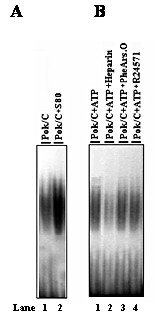
EMSA showing enhancement of binding activity of Nonabokra NE with 32P-1X ABRE-DNA after addition of the S80 fraction. A. Enhancement of the binding intensity by pre-incubation of control NE from Nonabokra with S80 fraction prepared from Nonabokra (200 mM NaCl for 16 hrs; lane 2). In lane 1, no S80 fraction was added. B. EMSA showing enhancement of complex formation after addition of ATP (lane 1). Partial inhibition of binding was obtained with heparin (a potent inhibitor of casein kinase II, lane 2), whereas no inhibition was obtained with phenyl arsine oxide (an indirect inhibitor of MAP kinase, lane 3) or R24571 (a potent inhibitor of CDPK, lane 4).